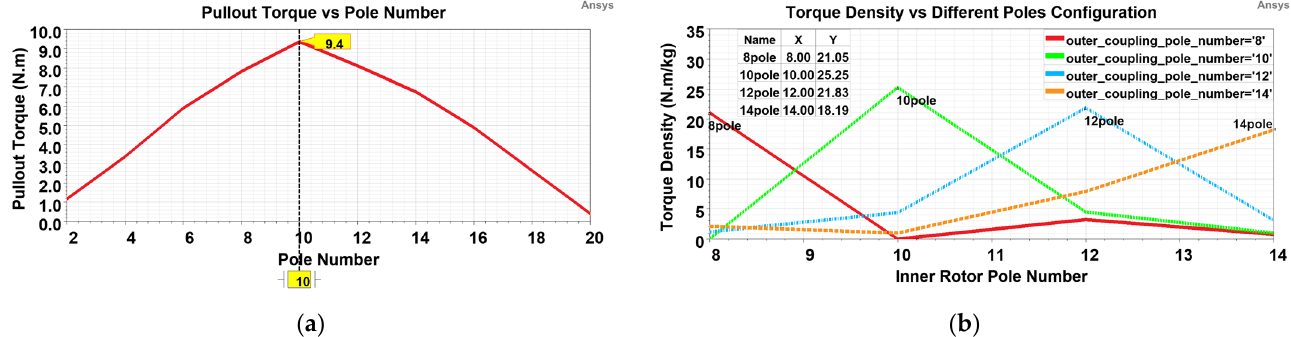
Figure 8. ( a ) Torque vs same rotor pole number; ( b ) Torque density vs different rotor pole number.